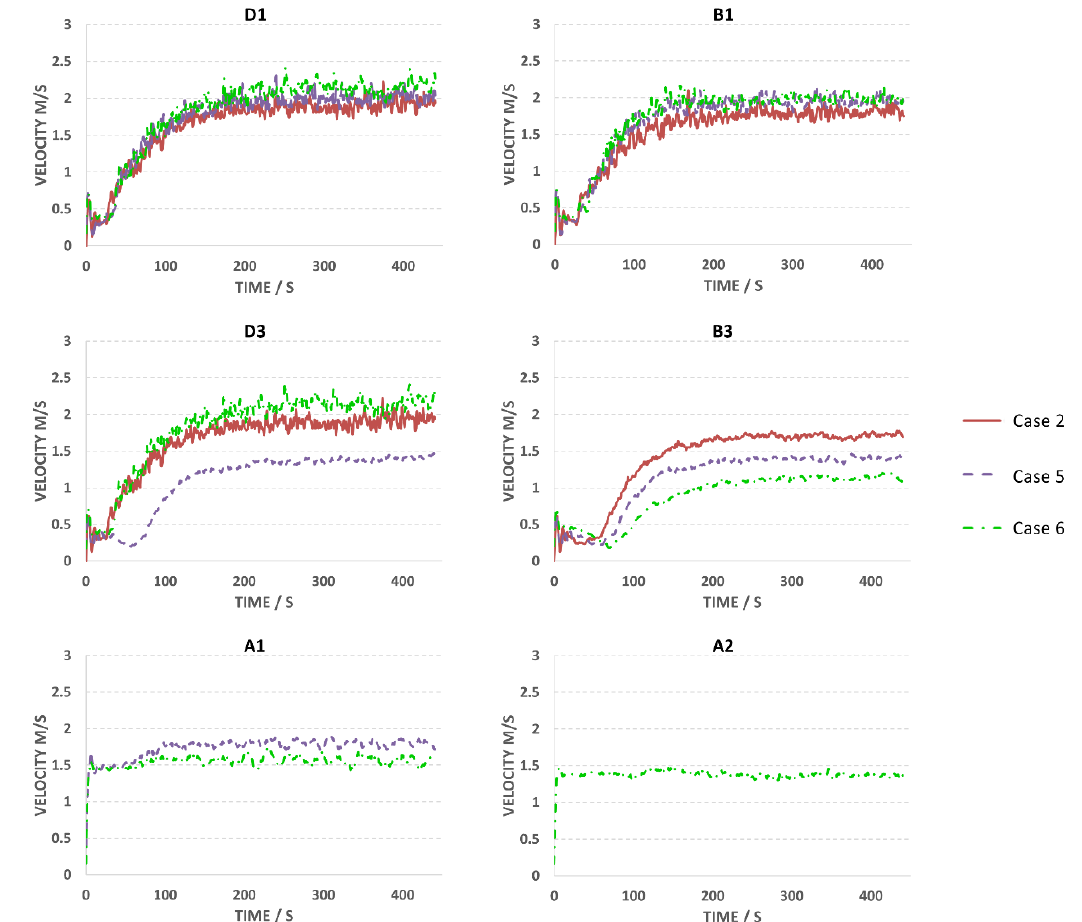
Figure 14. Average velocity measurements over time at various openings for Cases 2, 5, and 6 .